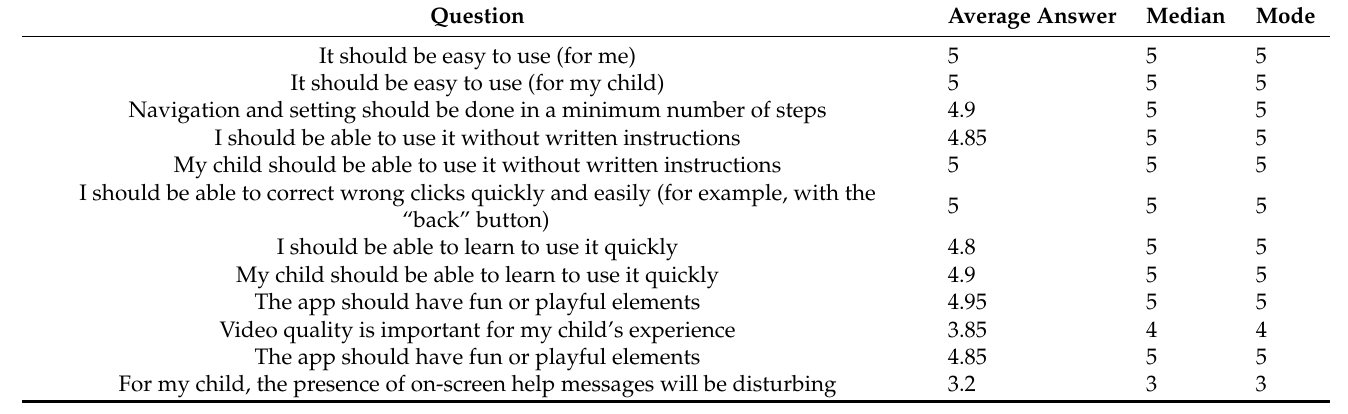
Table 1. Statistics of answers from the questions of the first questionnaire.